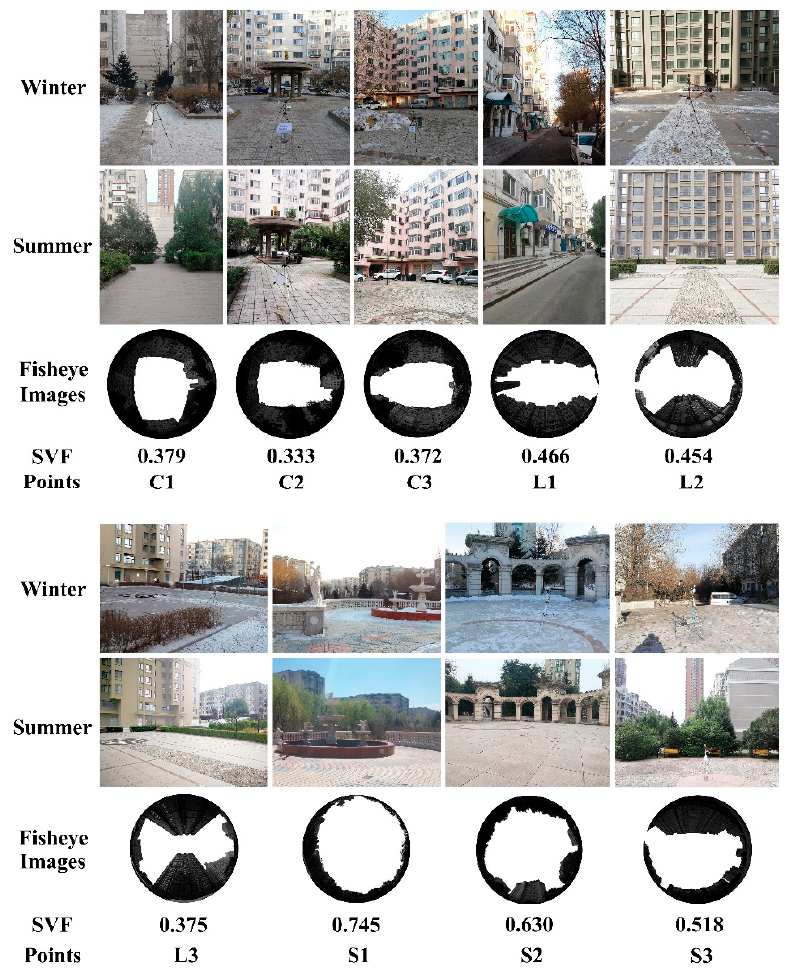
Figure 2. Site environments (winter and summer), fisheye images and SVF.